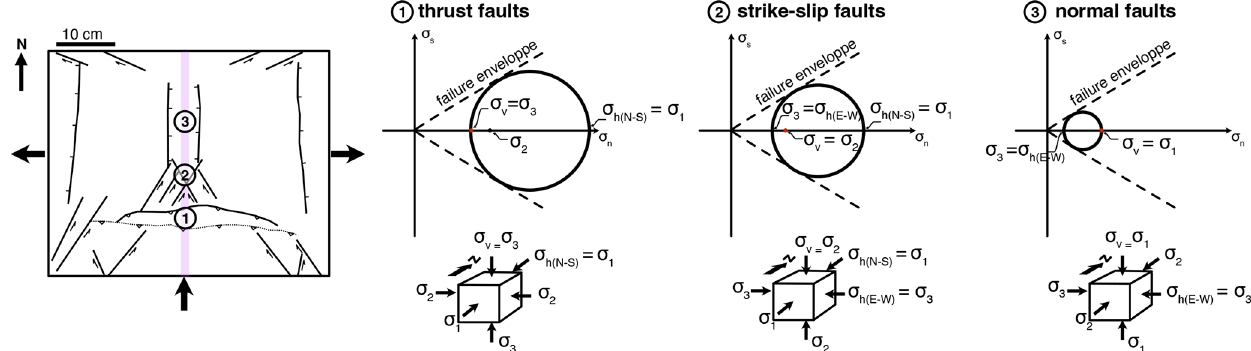
Figure 8. Interpreted distribution of structures for model BI05 after 7.7% of shortening and corresponding principal stress axis and Mohr– Coulomb analysis for the areas with labels 1, 2, and 3 on the left